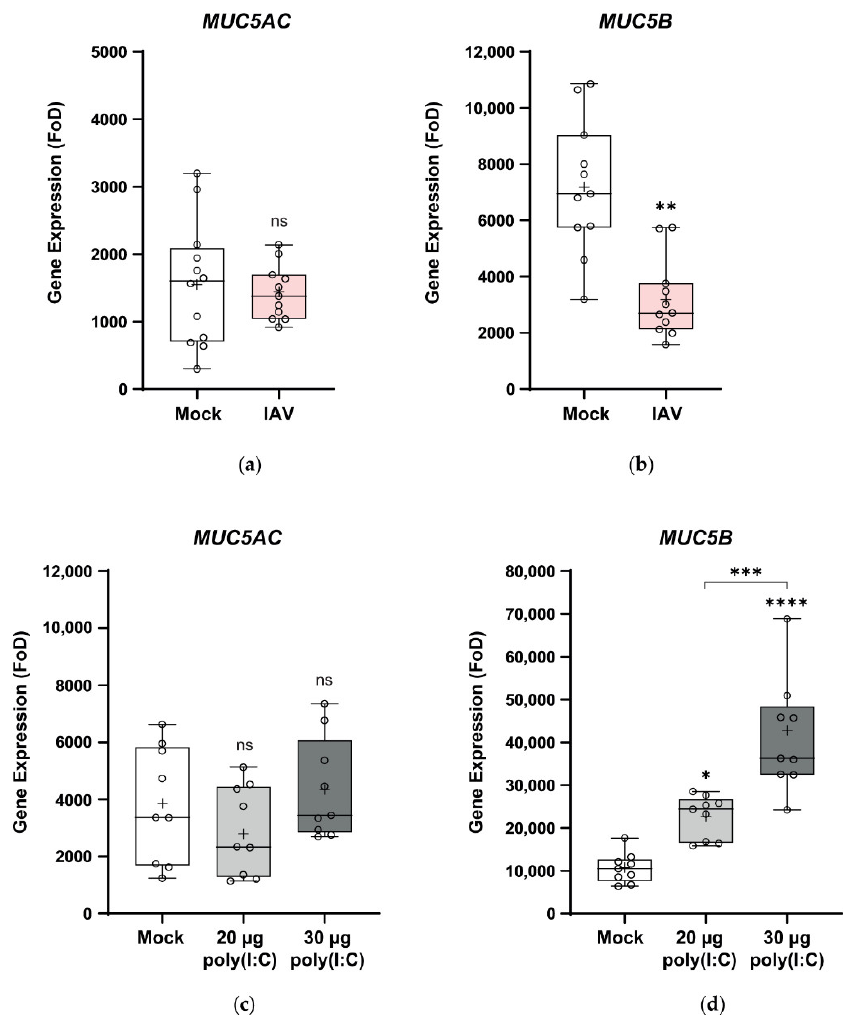
Figure 5. Expression of the MUC5AC and MUC5B genes in response to H1N1pdm09 and poly(I:C). The expression of MUC5AC and MUC5B in airlifted NHBE cells was assayed by RT-qPCR. ( a ) MUC5AC and ( b ) MUC5B expression 30 h postinfection with H1N1pdm09 (IAV) versus mock-inoculated cells and ( c ) MUC5AC and ( d ) MUC5B expression 48 h post-treatment with 20 µ g and 30 µ g poly(I:C) in comparison to mock-treated cells. Gene expression was normalized to GAPDH and is shown as fold over detectable (FoD), where the minimum level detectable was set at 40 cycles. Data from three independent experiments were pooled for each of IAV and poly(I:C) and are presented as box and whisker plots which show the mean ( + ), median, interquartile range and maximum and minimum values. The ends of each box represent the upper and lower quartiles, the horizontal line within the box indicates the median value and error bars show the minimum and maximum values. Individual values are depicted by open circles. IAV data: Mock, n = 12; IAV, n = 11 ( MUC5AC ) and Mock, n = 11; IAV, n = 11 for MUC5B ; poly(I:C) data n = 9 biological replicates per treatment. Statistical significance: ns, not significant; *, p < 0.05; **, p < 0.01; ***, p < 0.001; ****, p < 0.0001.